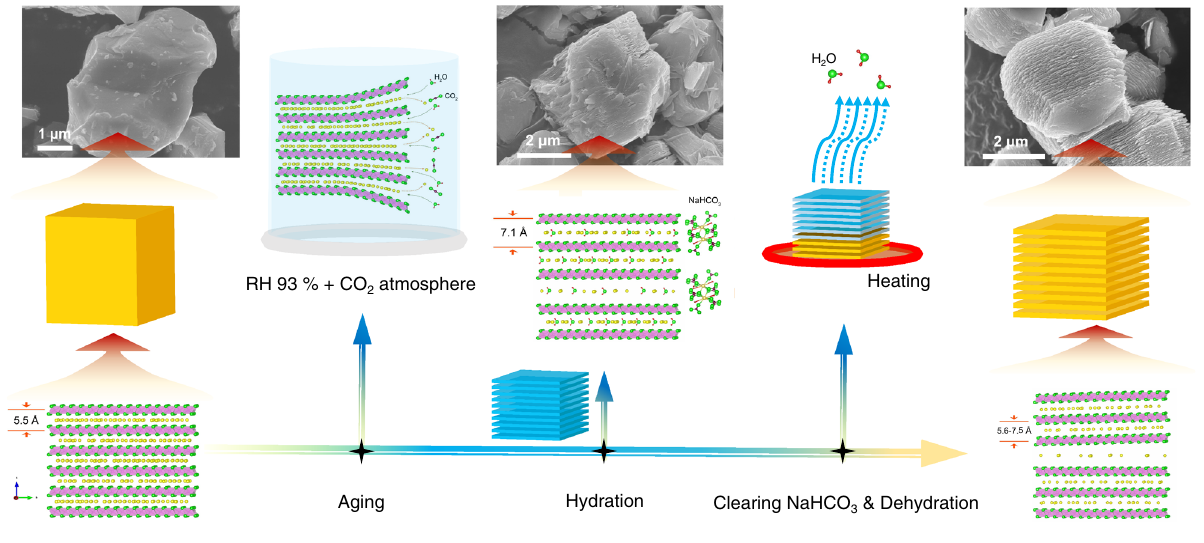
Na 0.67 MnO 2 Fig. 2 Water-mediated strategy. Schematic illustration of the preparation process of